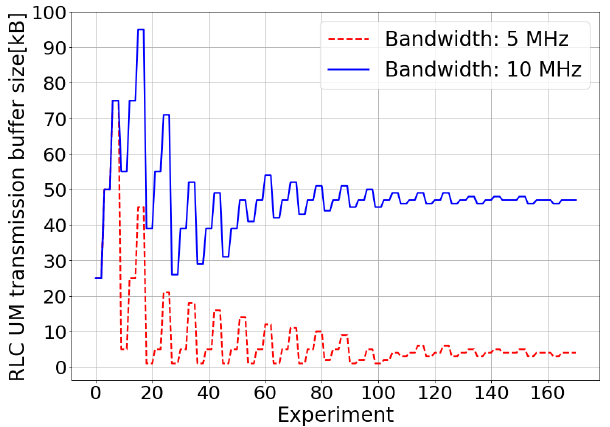
Figure 4. Simulated scenario—RLC UM transmission buffer